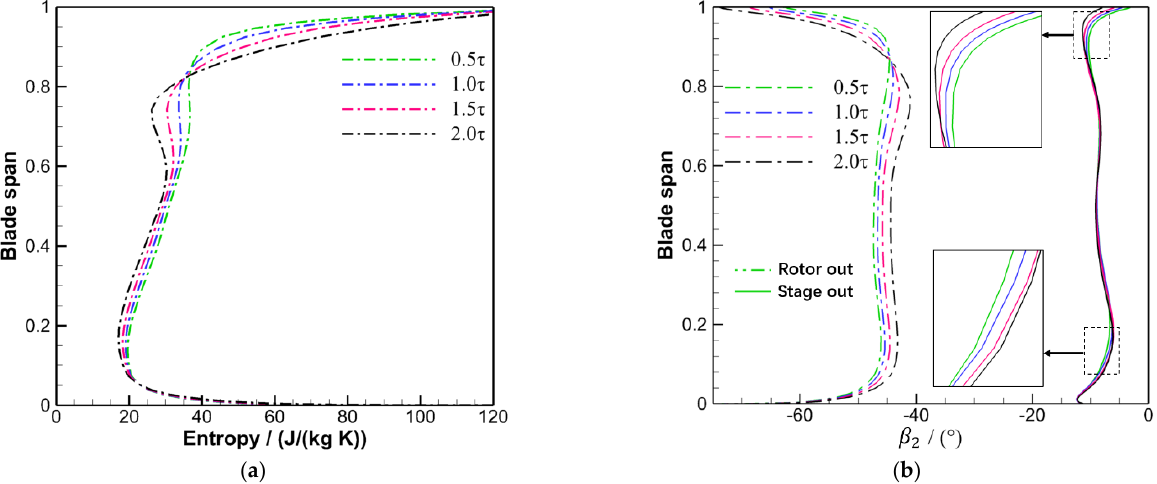
Figure 14. Limiting streamlines on the blade suction surface with different rotor tip clearances at P1: ( a ) Rotor; ( b ) Stator.